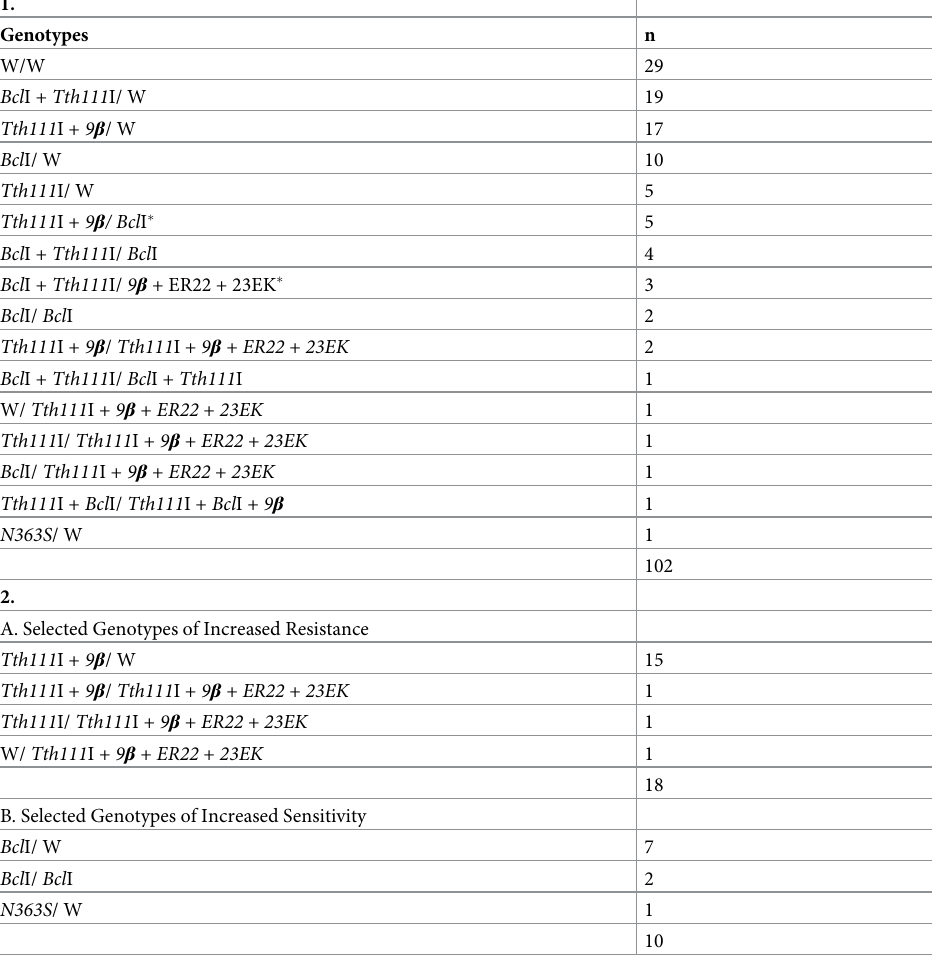
Table 3. 1) All genotypes (n = 102). 2) genotypes from final sample, listed according to GC increased resistance (A) or increased sensitivity (B) patterns in 21-OHD subjects (n =